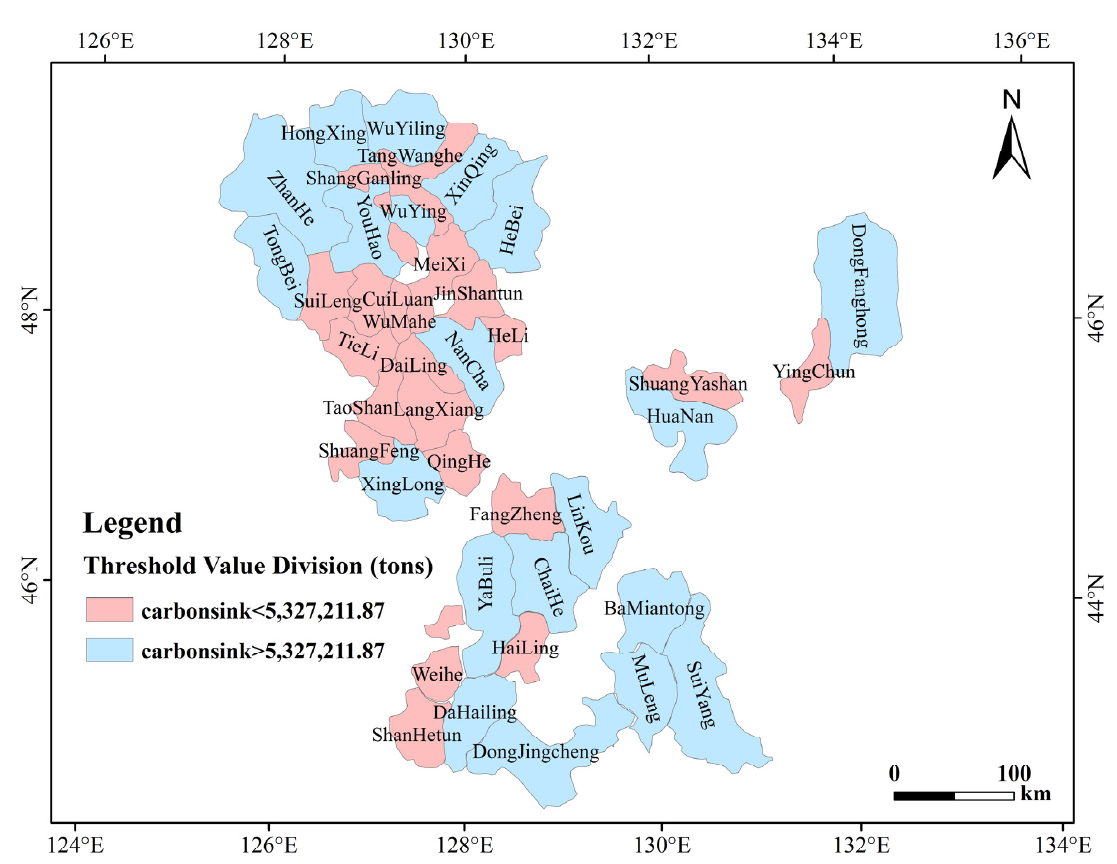
Figure 7. Division of sample units of threshold model.